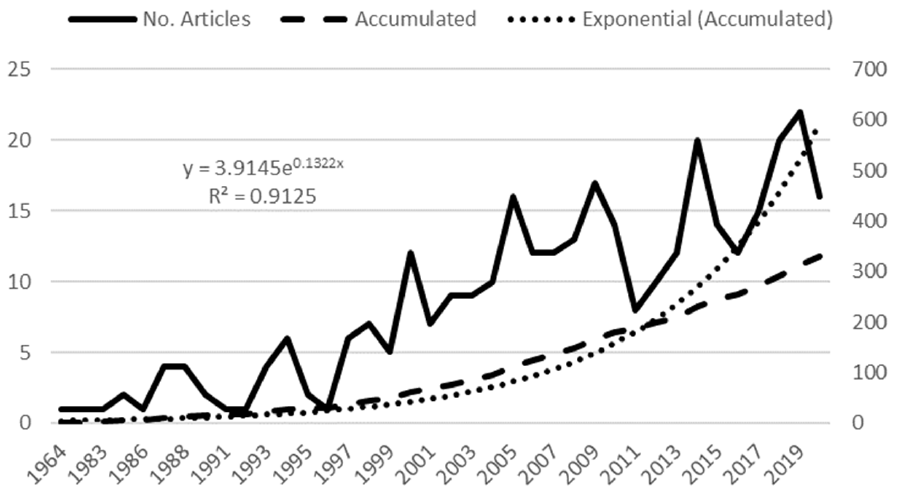
Figure 3. Growth curve and equation for the production of articles on the Water Market. Source: own elaboration.